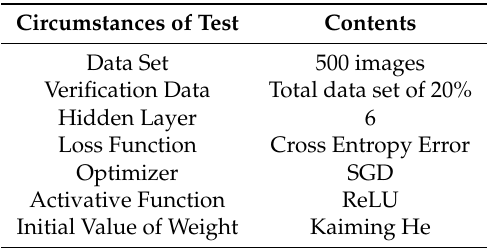
Table 2. Circumstances of test on